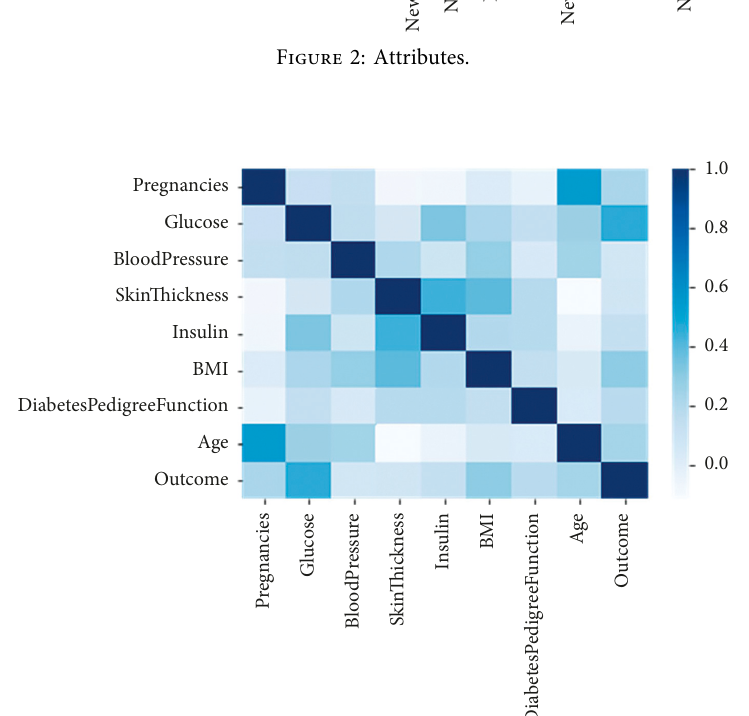
Figure 2: Attributes.